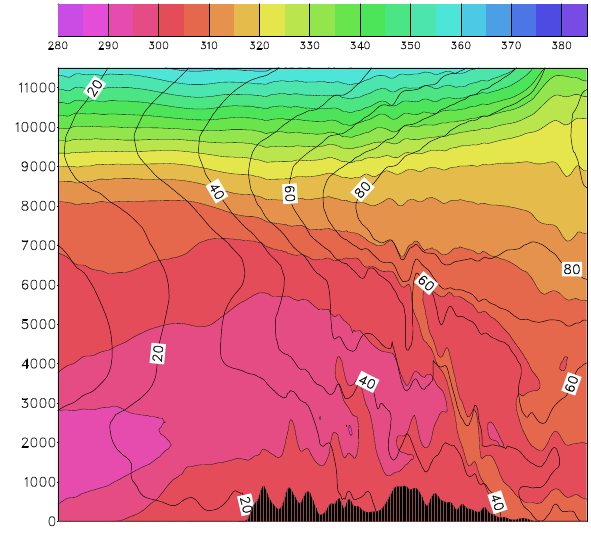
Fig. 10. Same as Fig. 9 on section y2 at 9:30 UT.